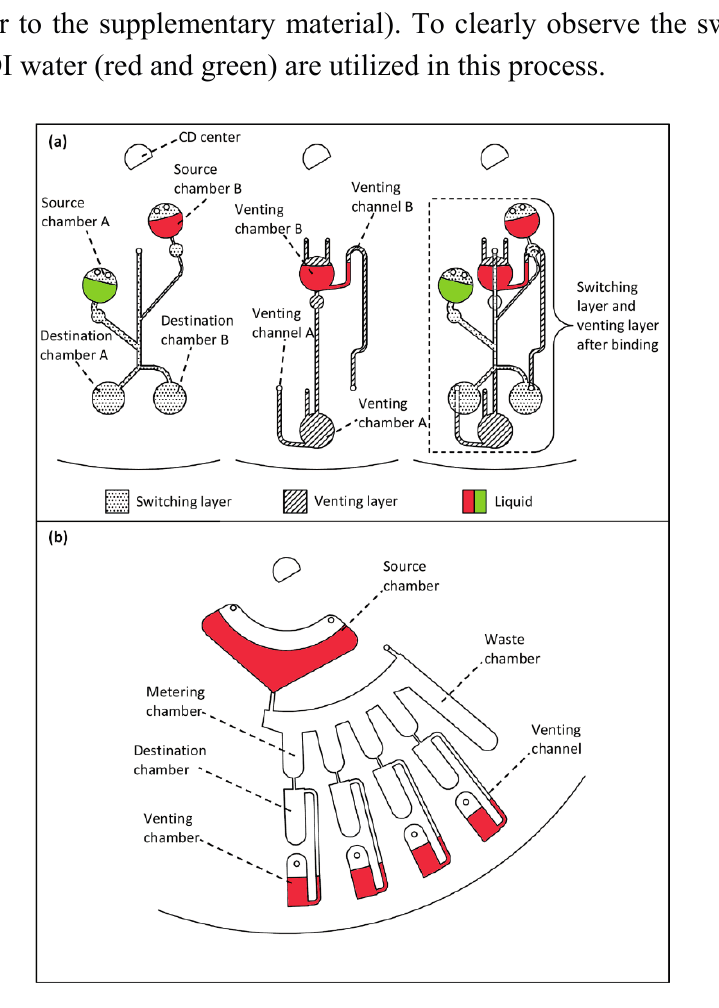
Figure 4. Microfluidic CD design for liquid switching and liquid metering ( a ) layer-by-layer design of the liquid switching process ( b ) design of the liquid metering